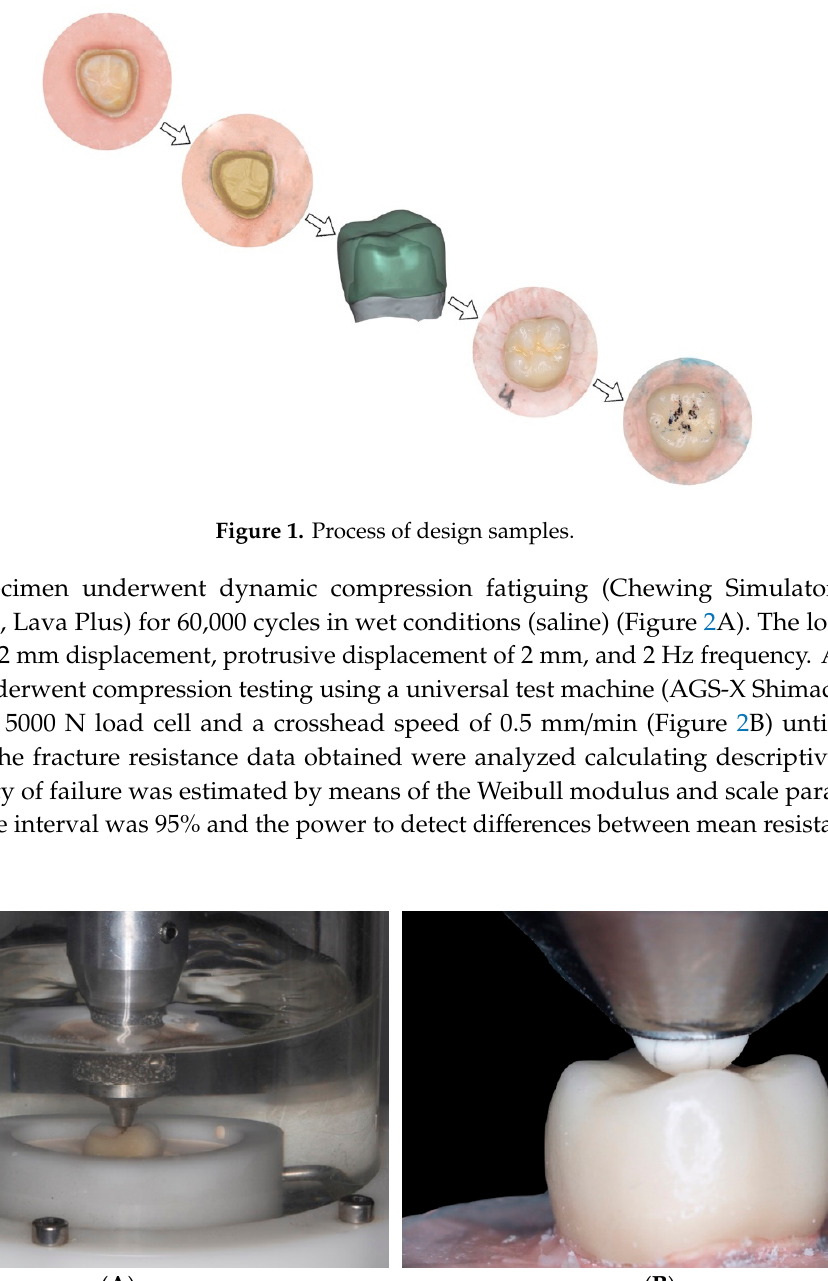
Table 1. Resistance results of each group after the dynamic and static test.